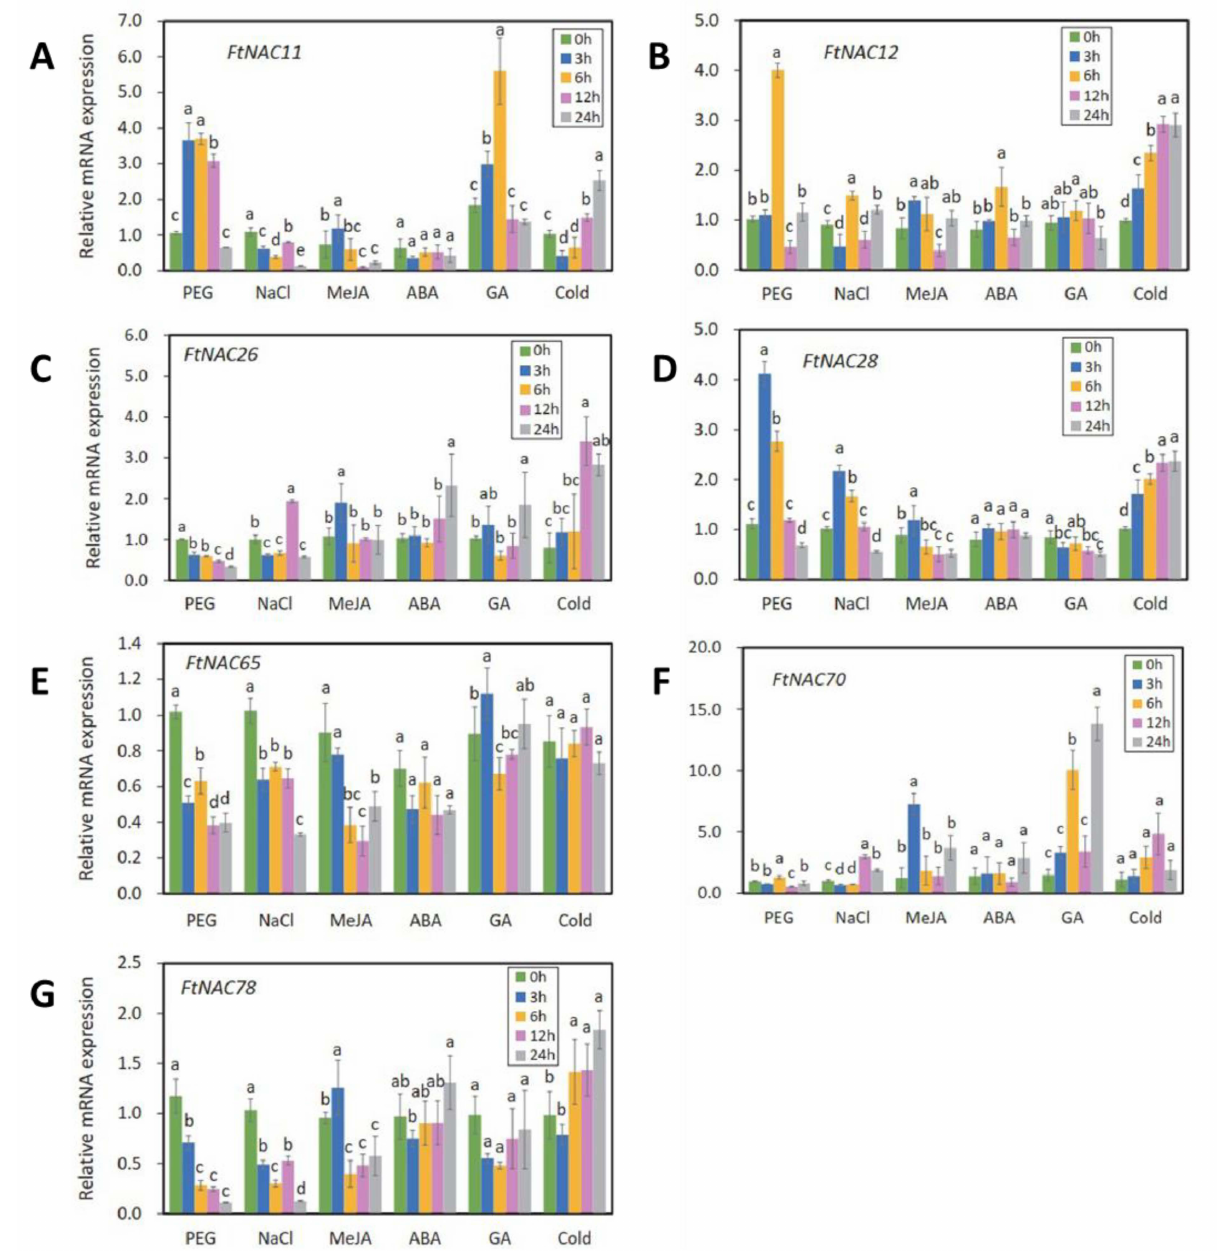
Figure 5. Expression analyses of seven FtNAC genes under PEG, NaCl, MeJA, ABA, GA, and cold treatment, namely FtNAC11 ( A ), FtNAC12 ( B ), FtNAC26 ( C ), FtNAC28 ( D ), FtNAC65 ( E ), FtNAC70 ( F ), and FtNAC78 ( G ). The columns indicate the means of the relative mRNA expression levels. The error bars indicate the standard deviations of the replicates. The lowercase letters show the statistical significance evaluated by Student’s t test. For one treatment, different lowercase letters indicate significant difference, whereas the same lowercase letters indicate no significant difference between two treatment